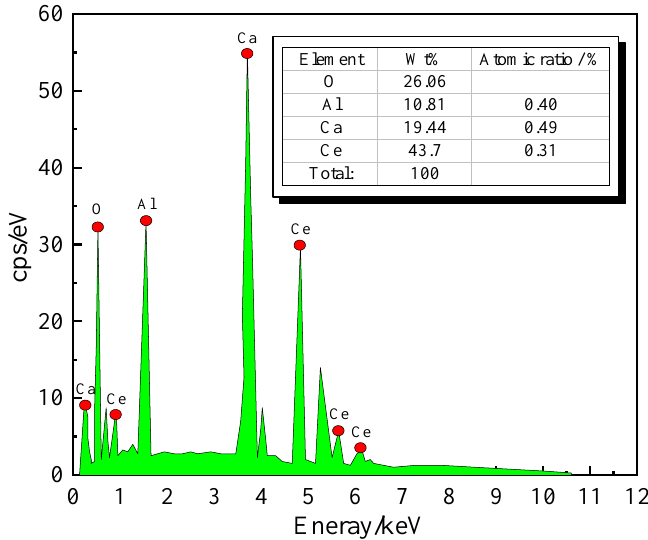
Figure 2. Secondary electron image, backscattered electron image, and element plane scanning of slag mineral-phase structure. ( a ) Refining slag +0% CeO 2 ; ( b ) Refining slag +5% CeO 2 ; ( c ) Refining slag +8% CeO 2 ; ( d ) Refining slag +10% CeO 2 ; ( e ) Refining slag +15% CeO 2 ; ( f ) Refining slag +20% CeO 2 .